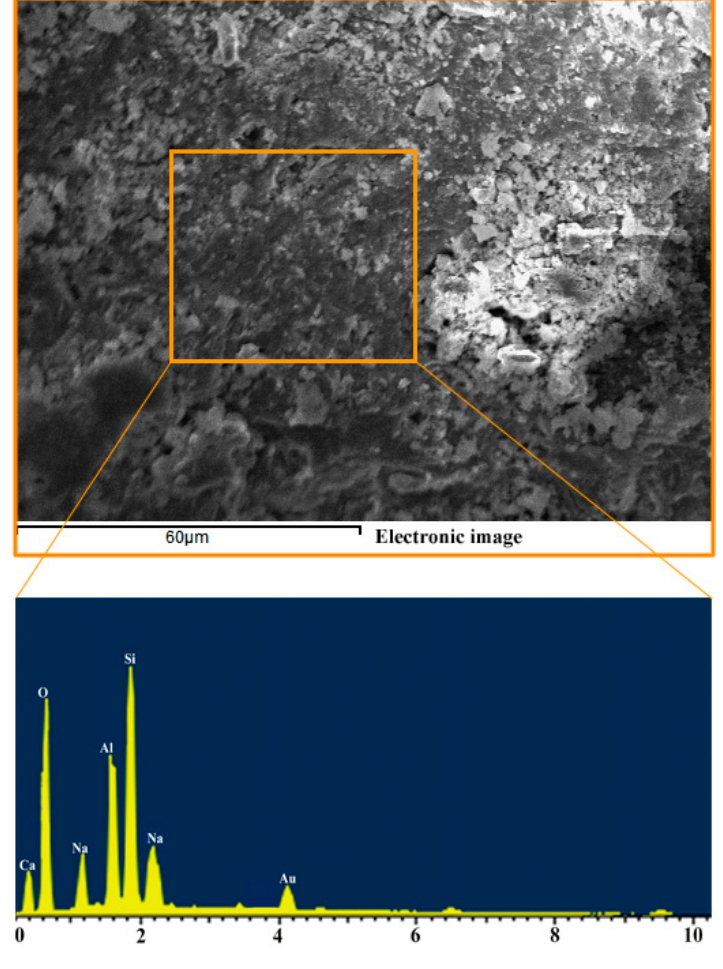
Figure 7. EDS spectrum of Si/Al = 1.9.